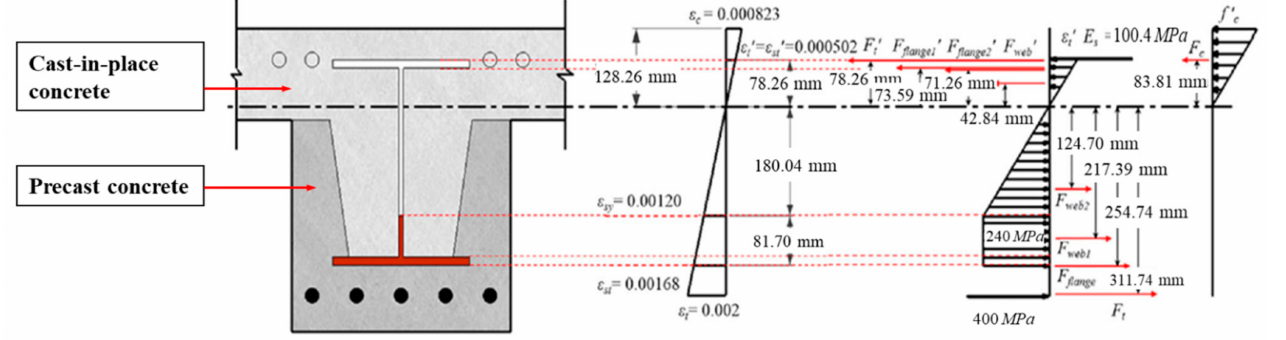
Figure 3. Strain and stress ( ε c = 0.000823) at the yield limit state for Specimen #10